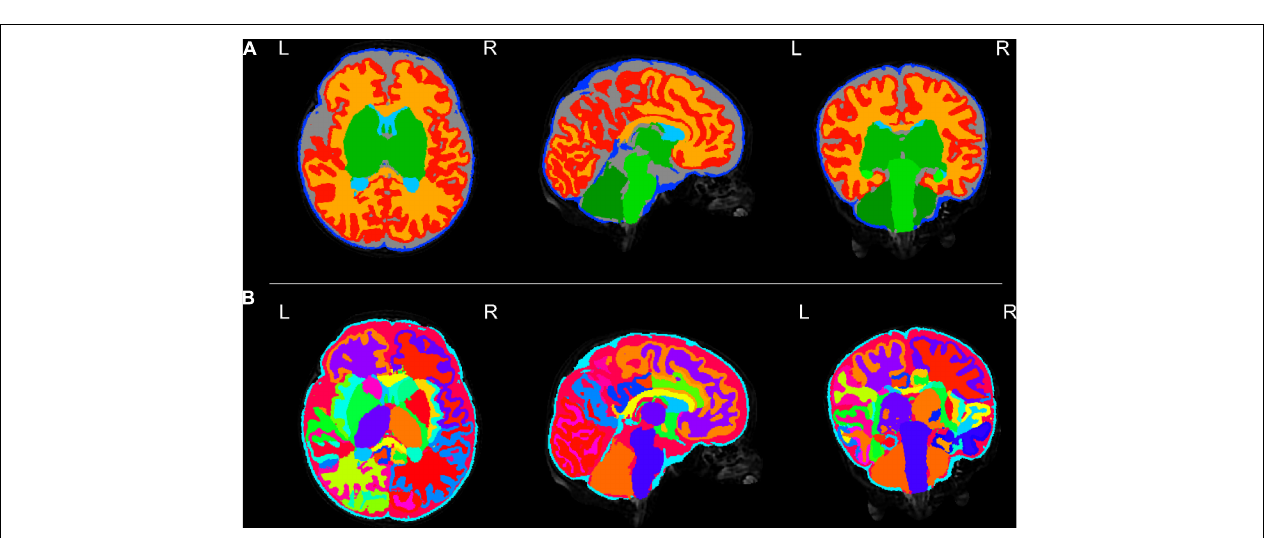
FIGURE 3 | Anatomical T1 and T2 weighted images before and after motion correction for one participant. ( A: top row) T1 native acquisition (left) with motion artifact visible in the left frontal region in the transverse plane (yellow arrow), which is resolved in the motion corrected images (right) after slice to volume reconstruction. ( B: bottom row) T2 native acquisition (left) with motion artifact visible in the sagittal plane (orange arrow), which is resolved in the motion corrected images (right).